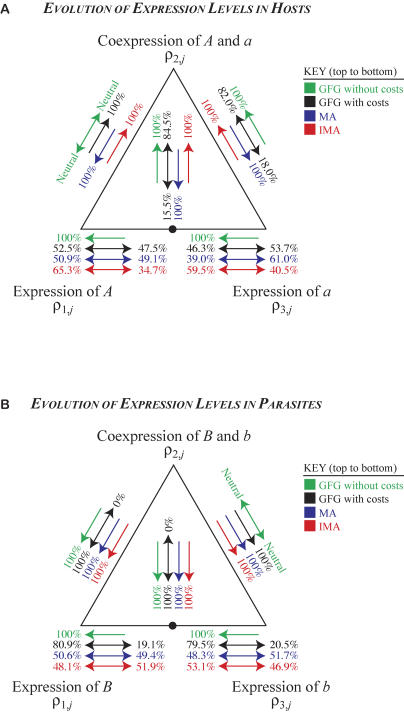
Expression Levels Are Allowed to Evolve toward Any Point in the TriangleFor example, the circle corresponds to the additive case, where heterozygotes are equally likely to express either A only or a only and so have fitness halfway between the fitnesses of AA and aa individuals. The evolution of expression levels predicted by the quasi-linkage equilibrium analysis is indicated by the direction of arrows. Double-headed arrows indicate that the quasi-linkage equilibrium analysis predicts an outcome that depends on allele frequencies. Results from numerical simulations are shown as percentages of total parameter combinations that resulted in evolution of expression levels in the direction shown. Entries labelled “neutral” are cases where no change in modifier frequency occured. The range of parameter values used in these simulations is described in the main text. Predicted patterns for the host are shown in (A), and those for the parasite are shown in (B).